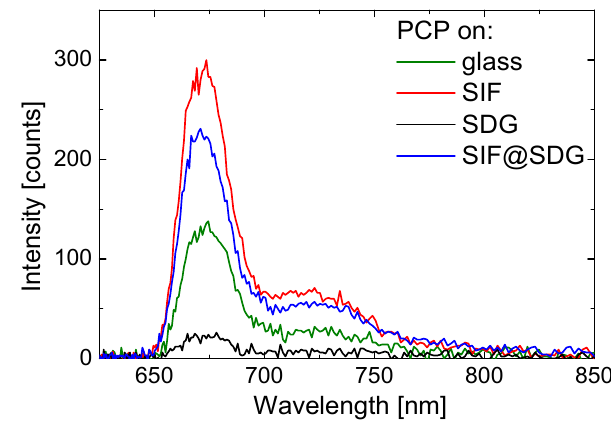
Figure 3. Fluorescence spectra measured for PCP on SIF (red), PCP on SDG (black), and PCP on SDG@SIF (blue). In addition the spectrum measured for PCP on glass is shown in green. The excitation wavelength was 485 nm.